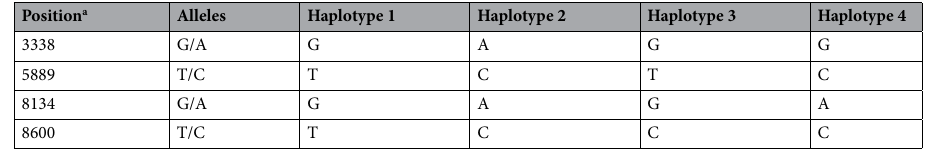
Table 1. Haplotype definitions. Haplotypes 1, 2, 3, and 4 were defined based on the combined occurrence of the four non-synonymous single nucleotide polymorphisms (SNPs) that have been linked to resistance in a previous study 21 . G3338A, T5889C, G8134A, and T8600C are located in mitochondrial genes coding for NADH dehydrogenase subunit (ND1), NADH dehydrogenase subunit (ND5), cytochrome c oxidase subunit (COX1), and cytochrome c oxidase subunit 3 (COX3). a Numbering according to a L. salmonis mitochondrial reference genome established for a Scottish isolate (NCBI Accession number LT630766.1).